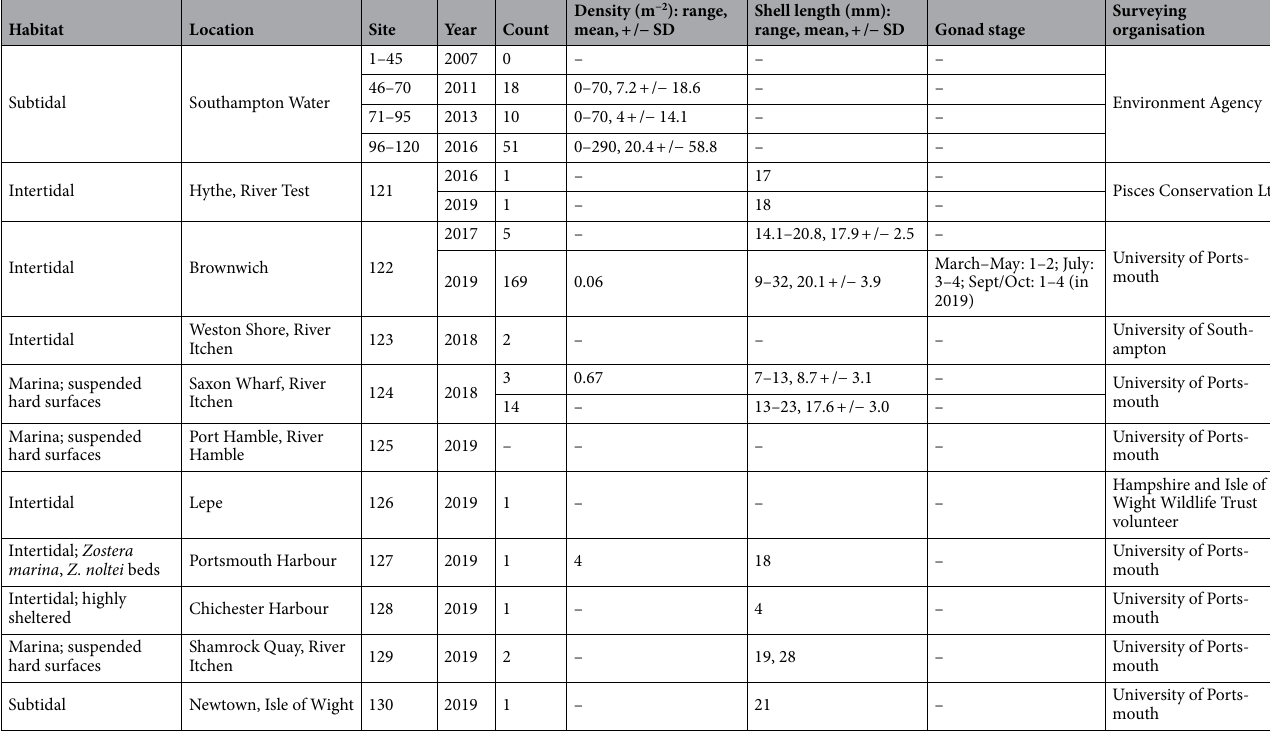
Table 1. Summary of A. senhousia population data from sites within the Solent region of the UK, recorded from 2007–2019. Site numbers correlate with Fig. 1. Gonad stages based on those of Sgro et al. 19 : “1–2” = spent or developing; “3–4” = ripe or spawning; “–” = data not